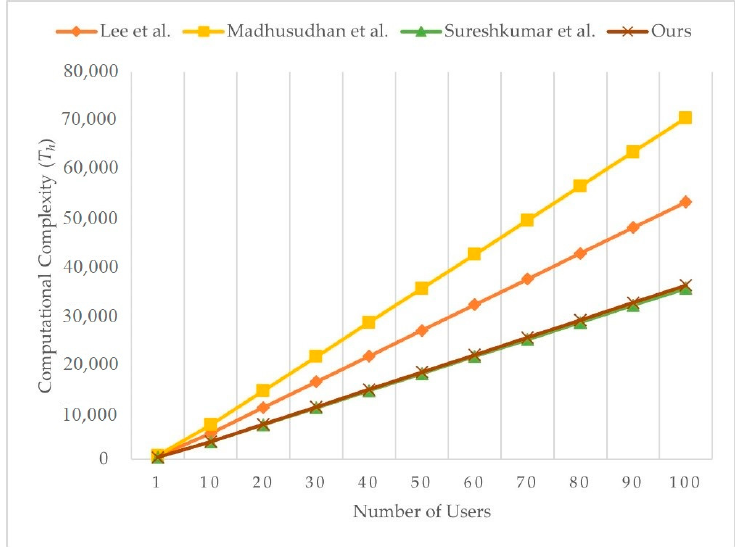
Sensors 2021 , 21 , x FOR PEER REVIEW Figure 10. Computational complexity of server with varying number of users. Figure 10. Computational complexity of server with varying number of users.